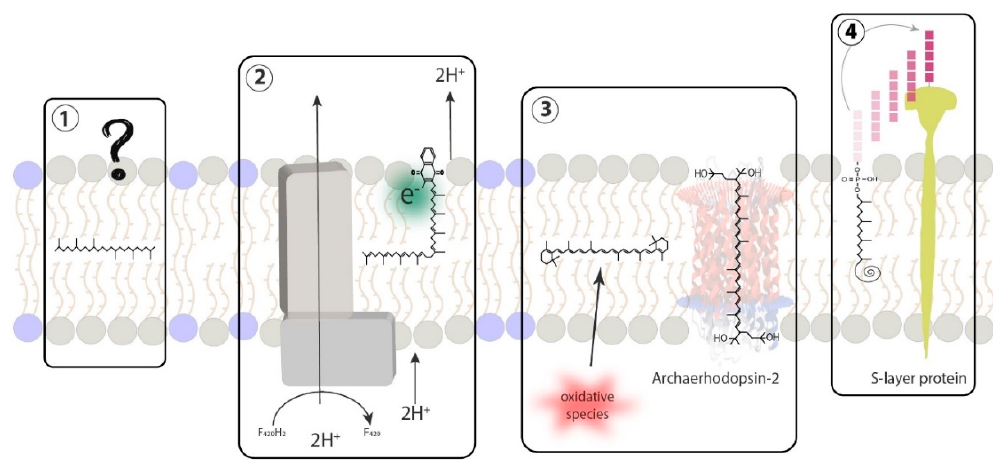
Figure 7. Schematic representation of major terpenoids found in Archaea and their respective biological functions. Blue and grey phospholipids represent archaeal tetraether and diether lipids, respectively. (1) squalane-type polyisoprenoids are widespread polyterpenes with yet-uncharacterized membrane function, (2) quinones are critical membrane-bound electron and proton carriers in energy transduction of various organisms, (3) carotenoids are well-characterized lipid-soluble antioxidants that may associate with transmembrane proteins and, (4) polyprenols are membrane-bound sugar carriers that are essential for transmembrane protein